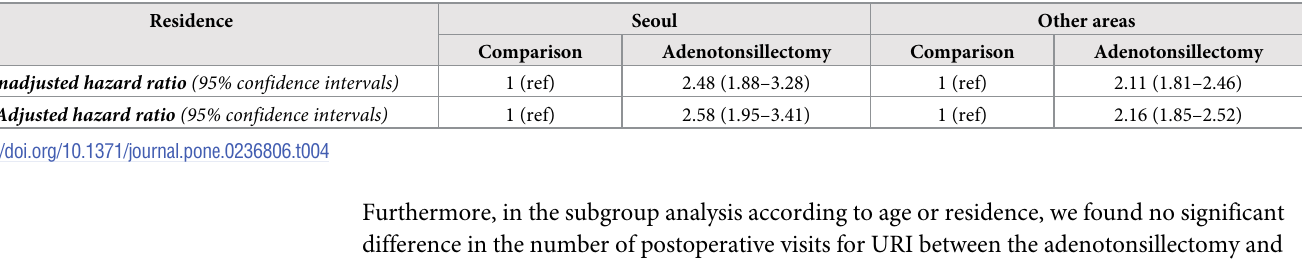
Table 4. Hazard ratios of asthma by residence.